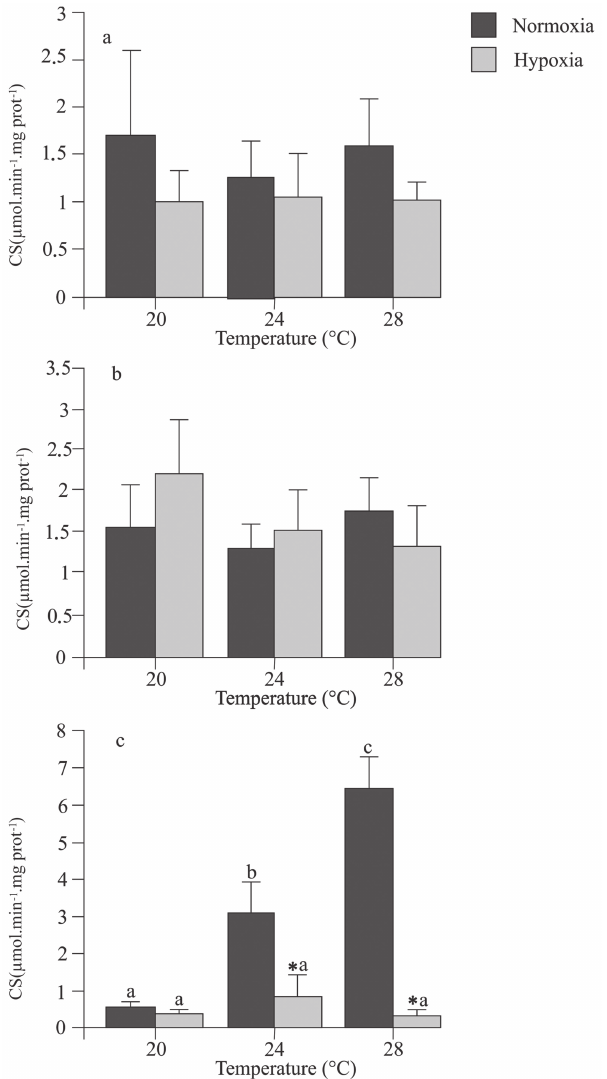
Fig. 2. Lactate Dehydrogenase enzyme activity of Geophagus Fig. 3. Citrate Synthase enzyme activity of Geophagus brasiliensis exposed to normoxic (90% oxygen saturation) brasiliensis exposed to normoxic (90% oxygen saturation) and hypoxic (20% oxygen saturation) conditions for 8 hours and hypoxic (20% oxygen saturation) conditions for 8 hours at 20°C, 24°C and 28°C. a. in liver; b. in white muscle; and at 20°C, 24°C and 28°C. a. in liver; b. in white muscle; and c. in heart. Asterisks indicates significant differences between c. in heart. Asterisks indicates significant differences between treatments at the same temperature, p < 0.05. Different treatments at the same temperature, p < 0.05. Different lowercase letters indicate significant differences for the same lowercase letters indicate significant differences for the same treatment at the temperatures studied, p < 0.05. treatment at the temperatures studied, p < 0.05. Tab. 3 . Enzimatic ratios in liver, muscle and heart in Geophagus brasiliensis exposed to 20°C, 24°C and 28°C in normoxia (90% oxygen saturation) and hypoxia (20% oxygen saturation) conditions for 8 hours. Temp. = Temperature; Cond. = Condition. Temp.